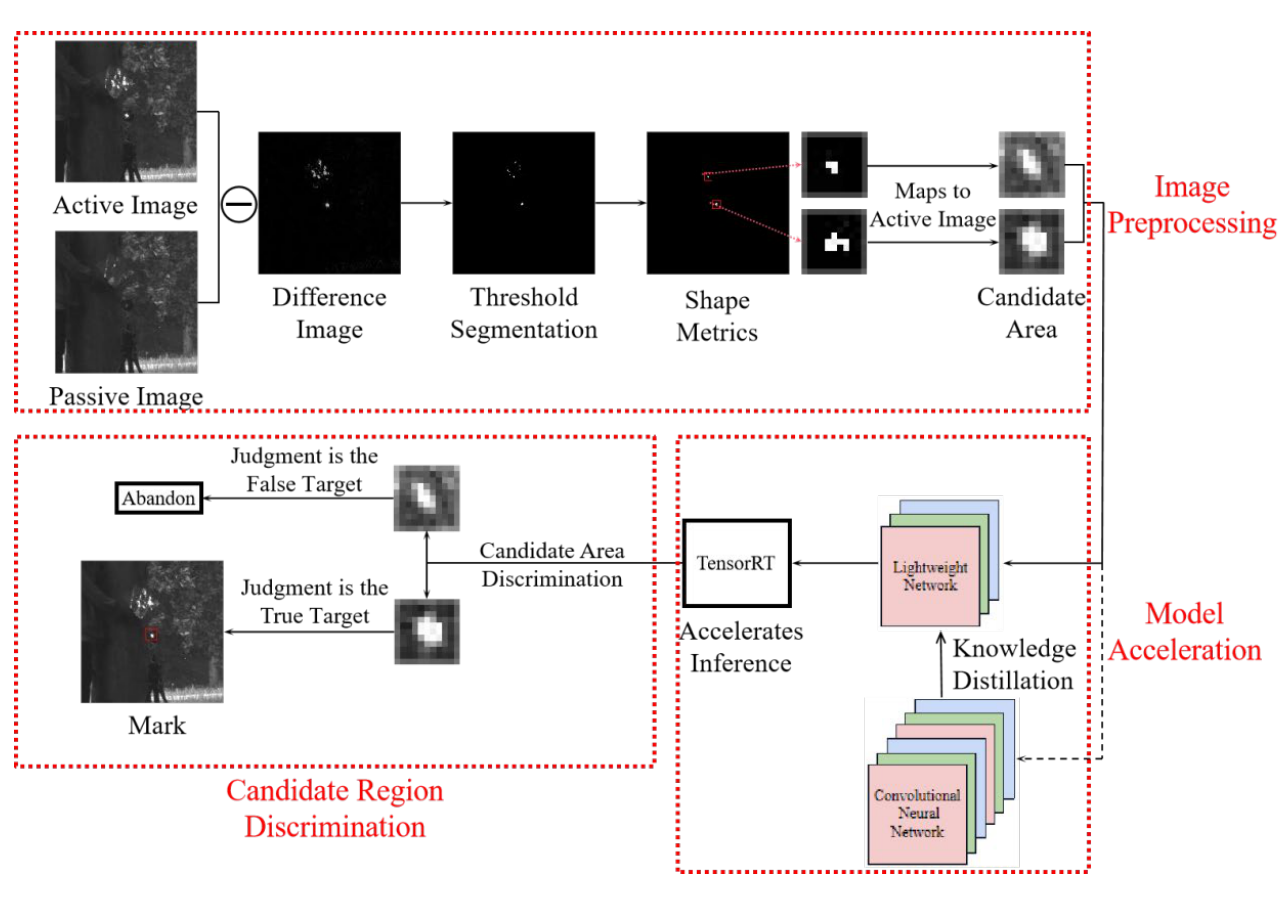
Figure 3. Algorithm flowchart of this article.